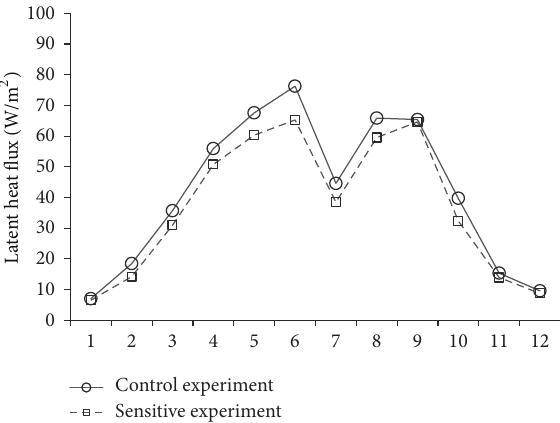
Figure 5: Average monthly change of latent heat flux (unit: W/m 2 ) in the overgrazing area of Northwest China from 2010 to 2040.